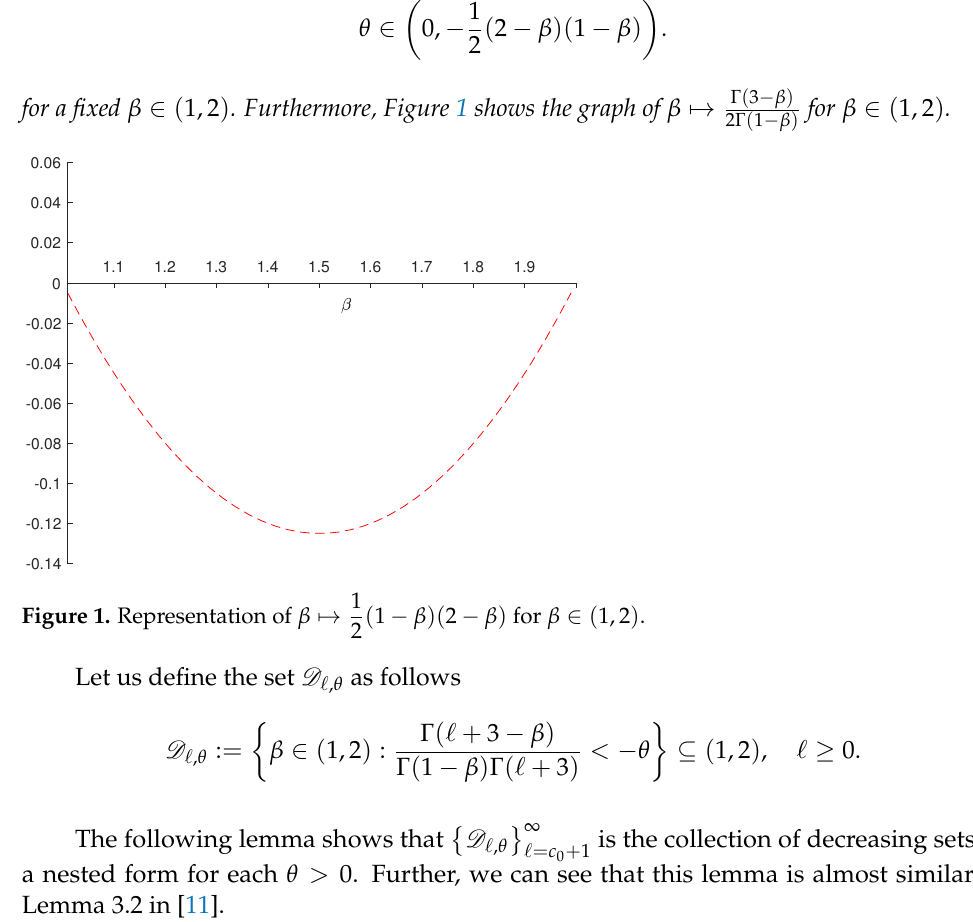
1 ( 1 − β )( 2 − β ) for β ∈ ( 1,2 ) 2